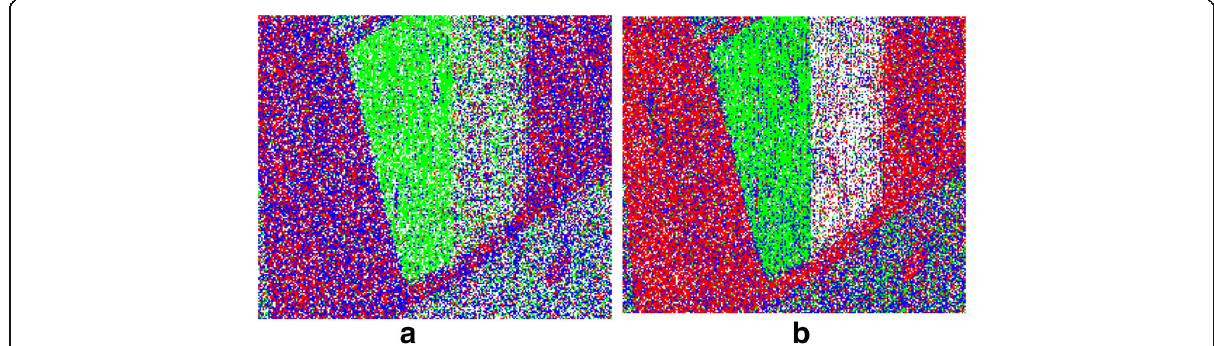
Fig. 5 The result of SVM classification. a The SVM classification of three polarimetric parameters. b The SVM classification of polarimetric parameters after reducing